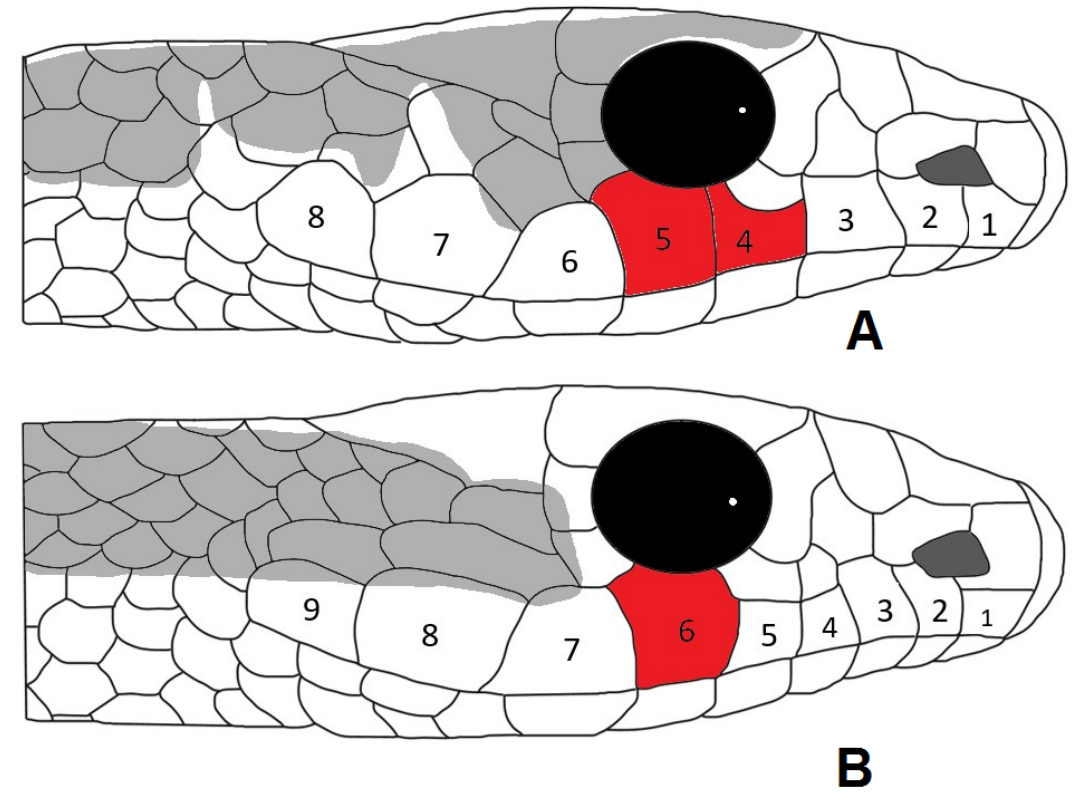
Fig. 14. A . Supralabials fourth and fifth in contact with the eye. B . Sixth supralabial in contact with the